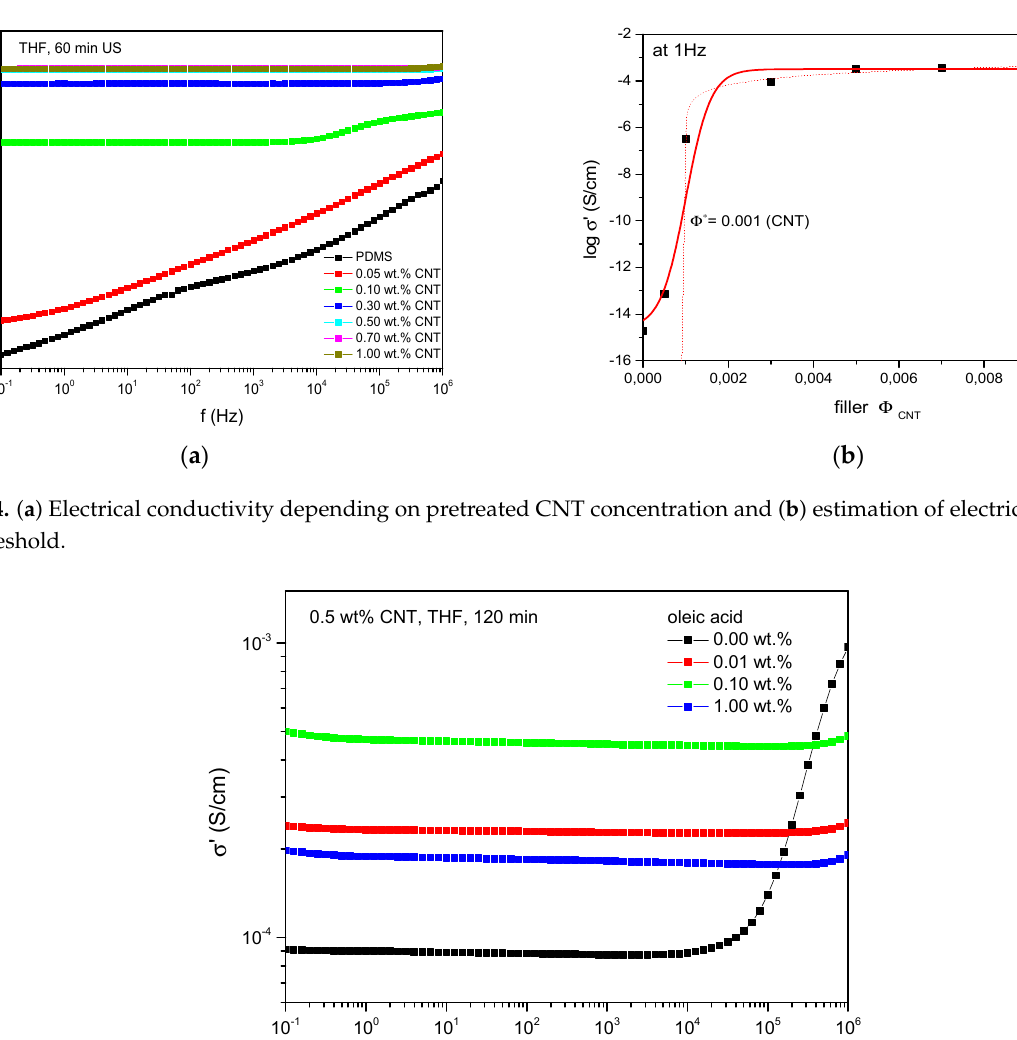
Figure 5. Dielectric conductivity depending on oleic acid concentration.